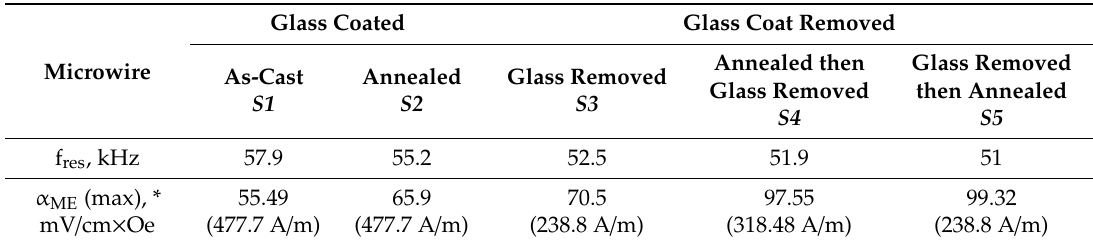
Table 2. Magnetoelectric parameters of composites with glass-covered and glass removed Fe 77.5 B 15 Si 7.5 microwires (* in parentheses, the value of the DC magnetic field at which α ME has a maximum is given). Glass Microwire